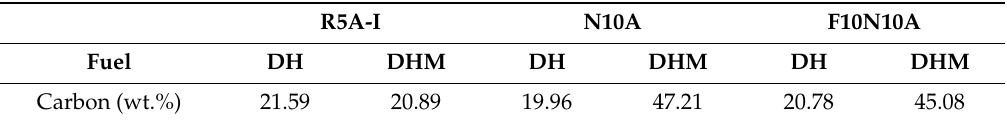
Table 2. Amounts of carbon on the catalytic surface of R5A-I, N10A, and F10N10A after 5-hour reactions at DH and DHM fuel. R5A-I N10A F10N10A Fuel DH DHM DH DHM DH DHM Carbon (wt.%)